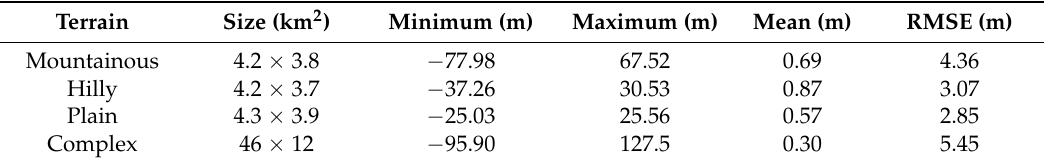
Figure 12. ( a – d ) Test area of Dengfeng city, China. ( a ) Image from the ZY3-02 NAD sensor; ( b ) image from the earlier digital orthophoto map (DOM); ( c ) digital surface model (DSM) from ZY3-02 triplet images visualized in color-shaded mode; ( d ) reference digital elevation model (DEM) visualized in color-shaded mode. Table 9. Statistics for the DSM height accuracy in Dengfeng over various terrain